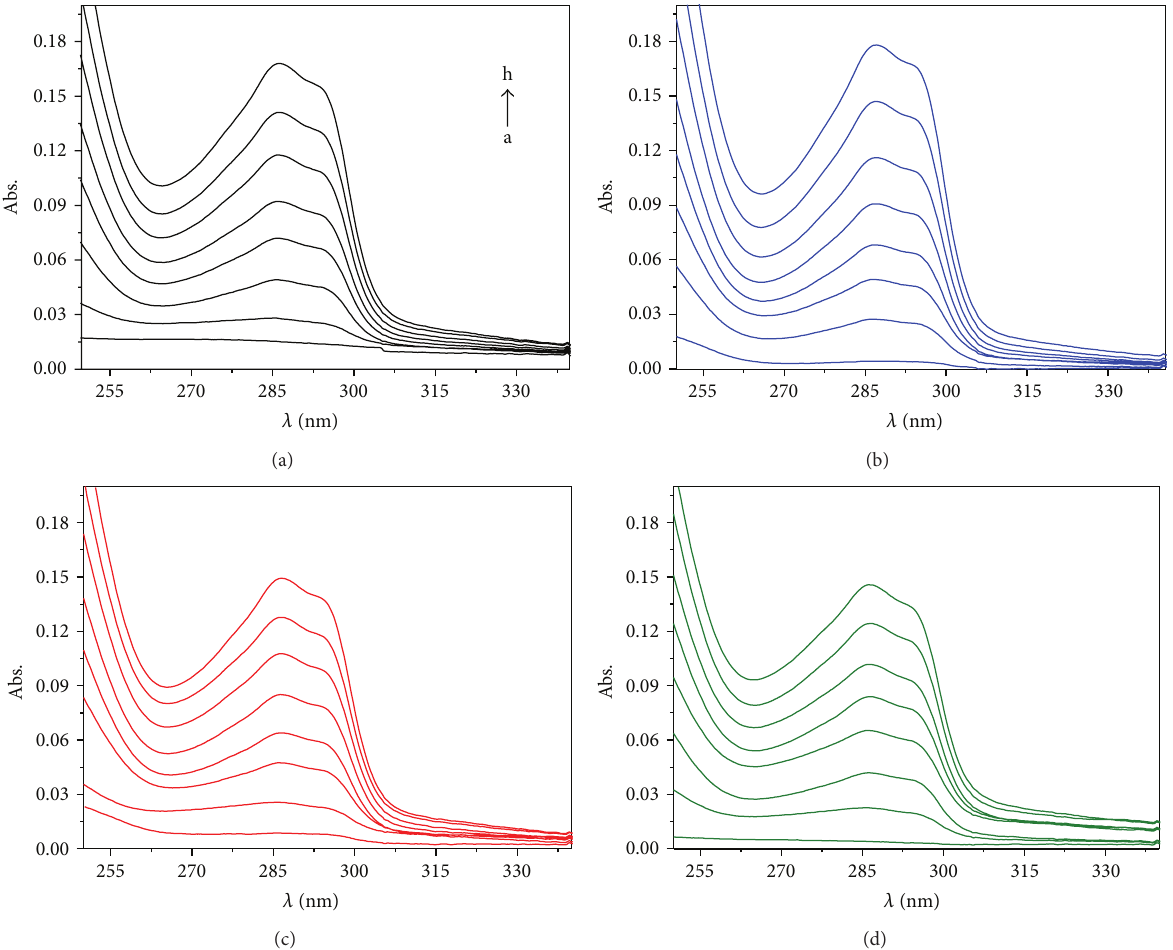
Figure 2: UV-Vis spectra of oxadiargyl in the presence of increasing concentrations: (a) 0; (b) 5; (c) 10; (d) 15; (e) 20; (f) 25; (g) 30; (h) 35mM of HP- 𝛽 -CD in (Black Line) ultrapure water, (Blue Line) acetate buffer pH 3.5, (Red Line) acetate buffer pH 5.3, and (Green Line) phosphate buffer pH